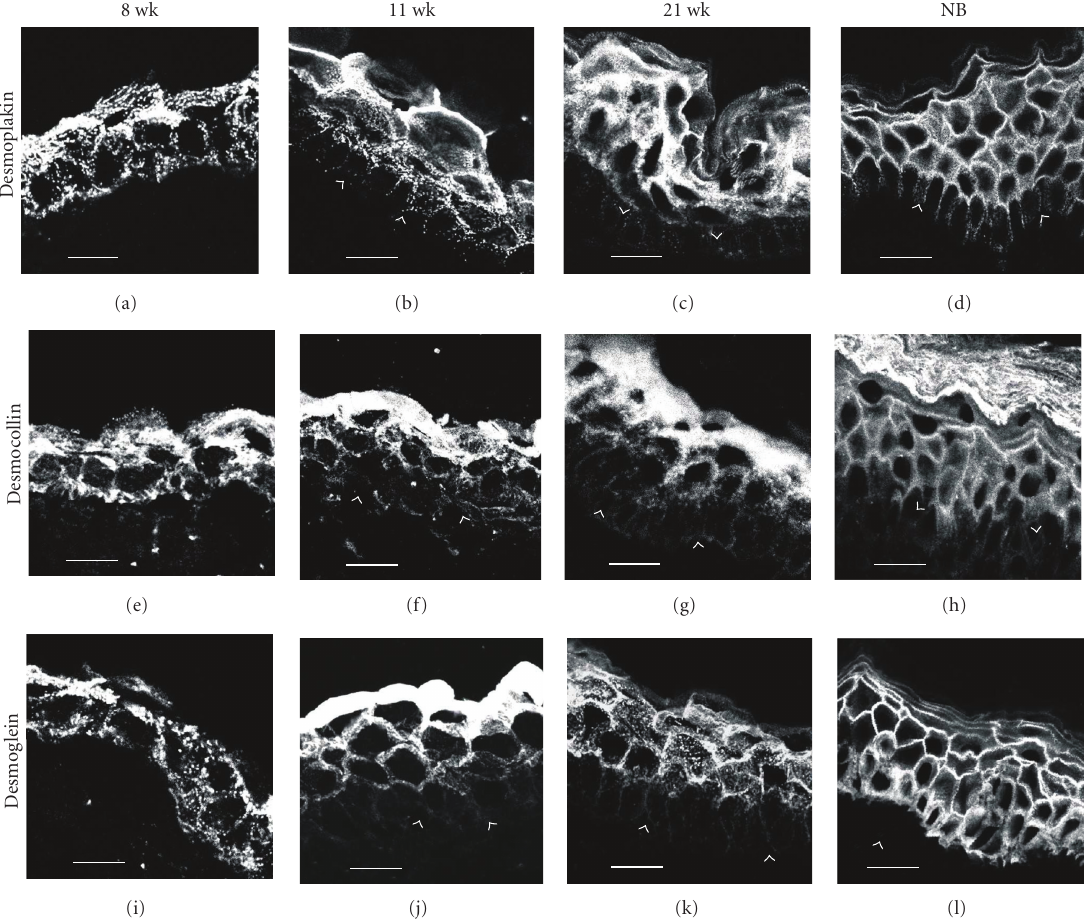
Figure 2: Expression and localization of desmosomal proteins in developing human skin at 8, 11, and 21 weeks of EGA and at newborn age (NB). Note the gradual increase in the density of desmosomes. At 8 weeks EGA, the epidermis is composed of basal and peridermal cell layers (a, e, i). Antibodies to desmoplakin (a), desmocollin (e), and desmoglein (i) label cell membranes of basal and peridermal cells. Note also immunolabeling in the dermal-epidermal junction. At 11 weeks EGA, the intermediate cell layer has developed in the epidermis (b, f, j). An intense signal for desmoplakin (b), pan-desmocollin (f), and pan-desmoglein (j) is apparent in the peridermal cells. Intermediate cells also show desmosomal antigens, while lateral membranes of basal cells are almost devoid of these desmosomal proteins. At 21 weeks EGA, the peridermal cell layer has been shed and the epidermis is composed of the four definitive layers of epidermis (c, g, k). Desmoplakin (c), desmocollin (g), and desmoglein (k) antibodies label all the cell layers, the basal cells being only weakly labelled ( arrowheads point to the dermal-epidermal junction; bars (a, e, i) 10 μ m, (b, c, d, f, g, h, j, k, i) 20 μ